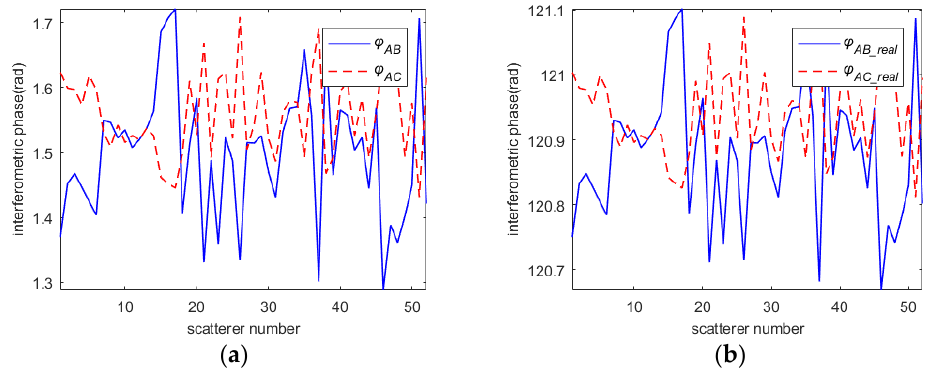
Figure 7. Interferometric phases: ( a ) before InPha restoration; ( b ) after InPha restoration.